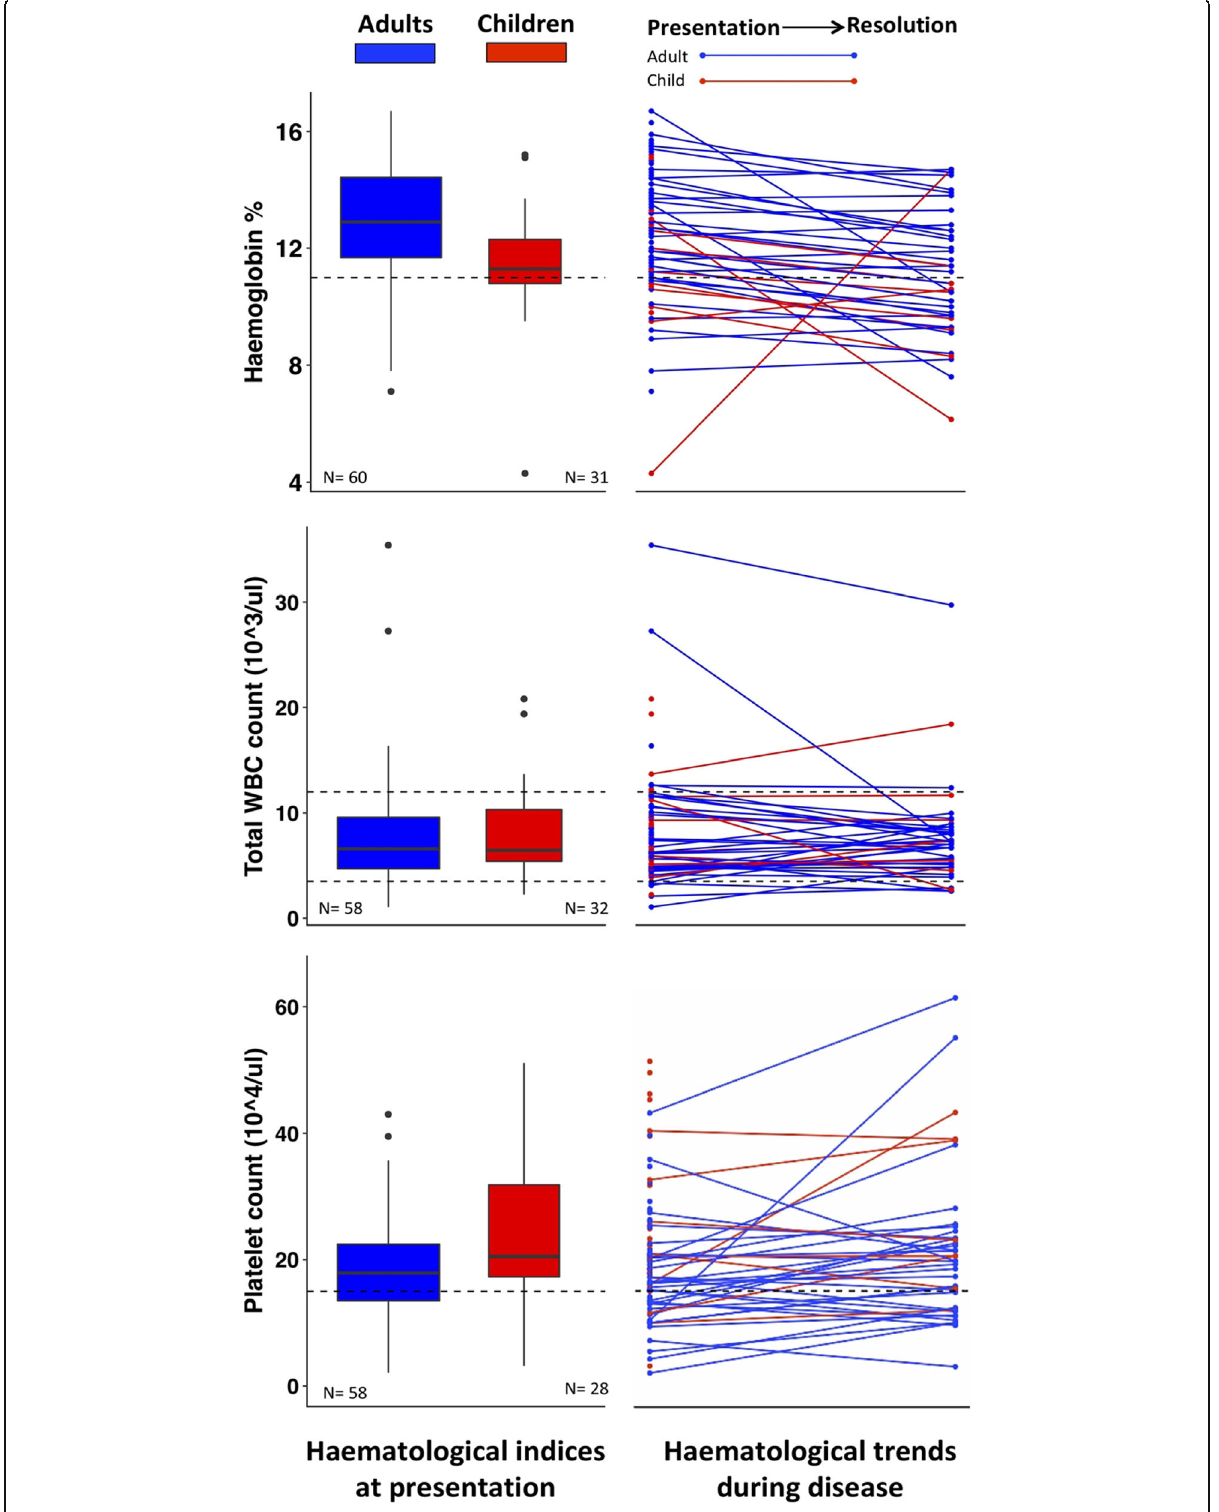
Fig. 2 Haematological parameters of cases identified through this study. Haematological values of patients infected with typhoidal Salmonella on admission and trends over the course of disease according to inset legend. The dashed lines represent the cut-offs for the haematological